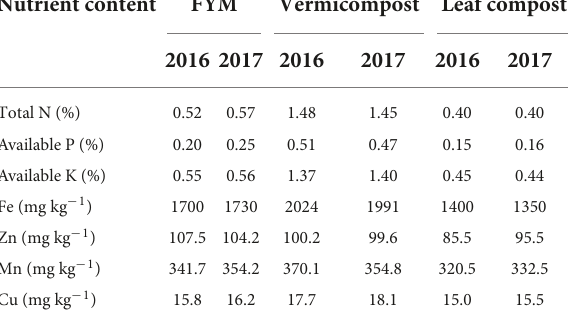
TABLE 3 Chemical composition of FYM, vermicompost, and leaf compost used in the